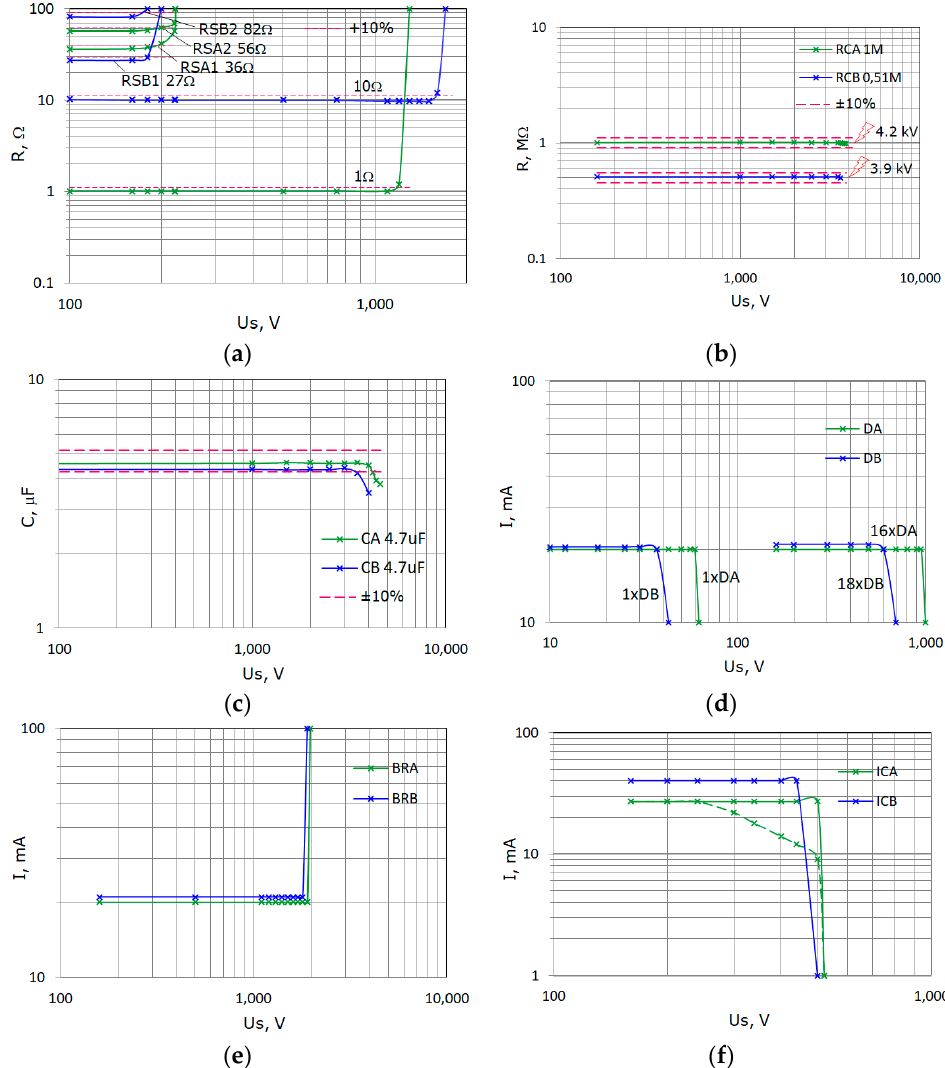
Figure 6. Sensitivity of the components of lamp A and B to a surge of 1.2/50 µs (8/20 µs): ( a , b ) resistors, ( c ) capacitors, ( d ) LEDs, ( e ) rectifiers, ( f ) current stabilizers.